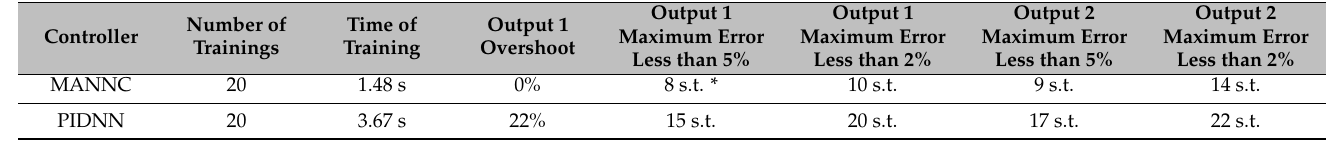
Table 5. Case 1: MANNC vs.